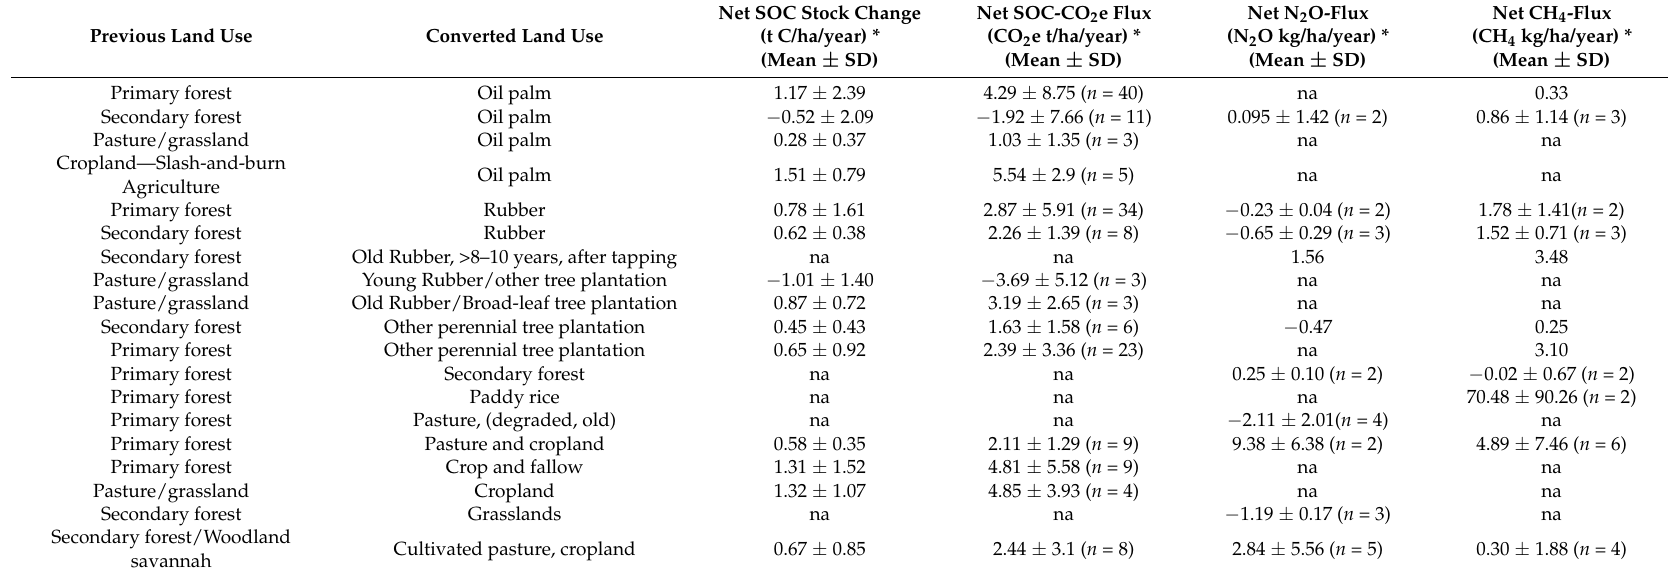
Table 2. Summary of GHG fluxes for different land use changes (data source cited in Tables